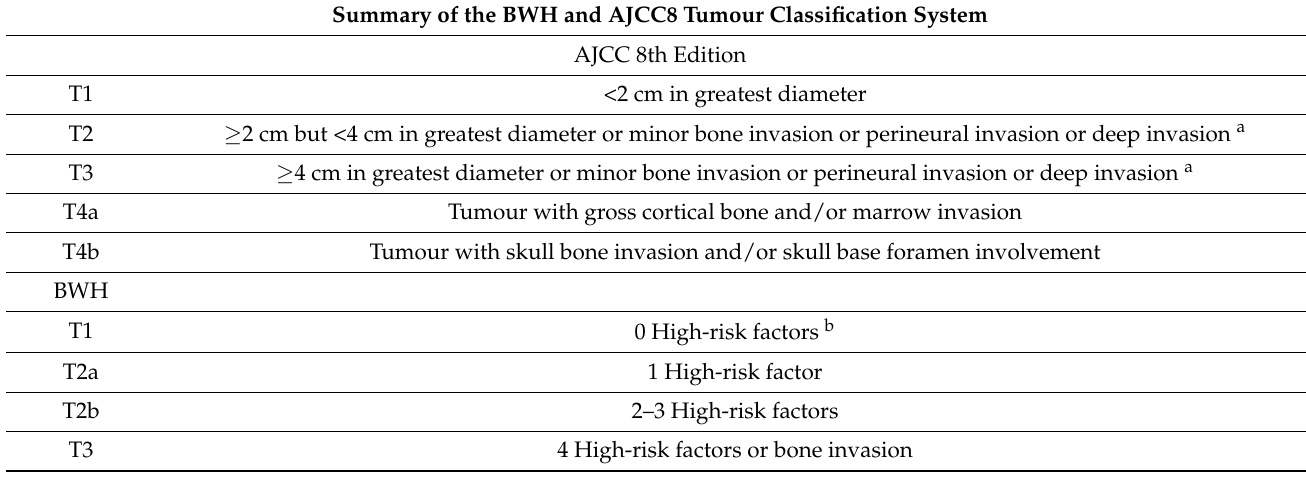
Table 1. Summary of the BWH and AJCC eighth edition classification systems for cutaneous squamous cell carcinoma. Summary of the BWH and AJCC8 Tumour Classification System